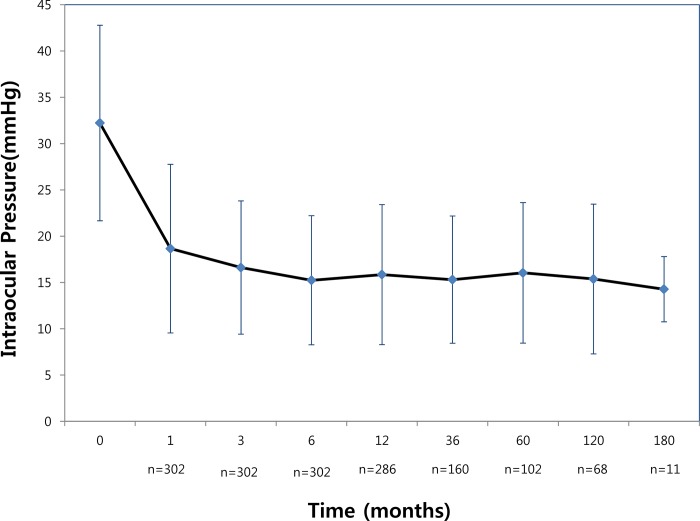
Mean intraocular pressure(IOP) before surgery and during follow-up.The intervening mean postoperative IOPs were significantly reduced compared to baseline during entire postoperative periods. Error bars indicate 1 standard deviation.